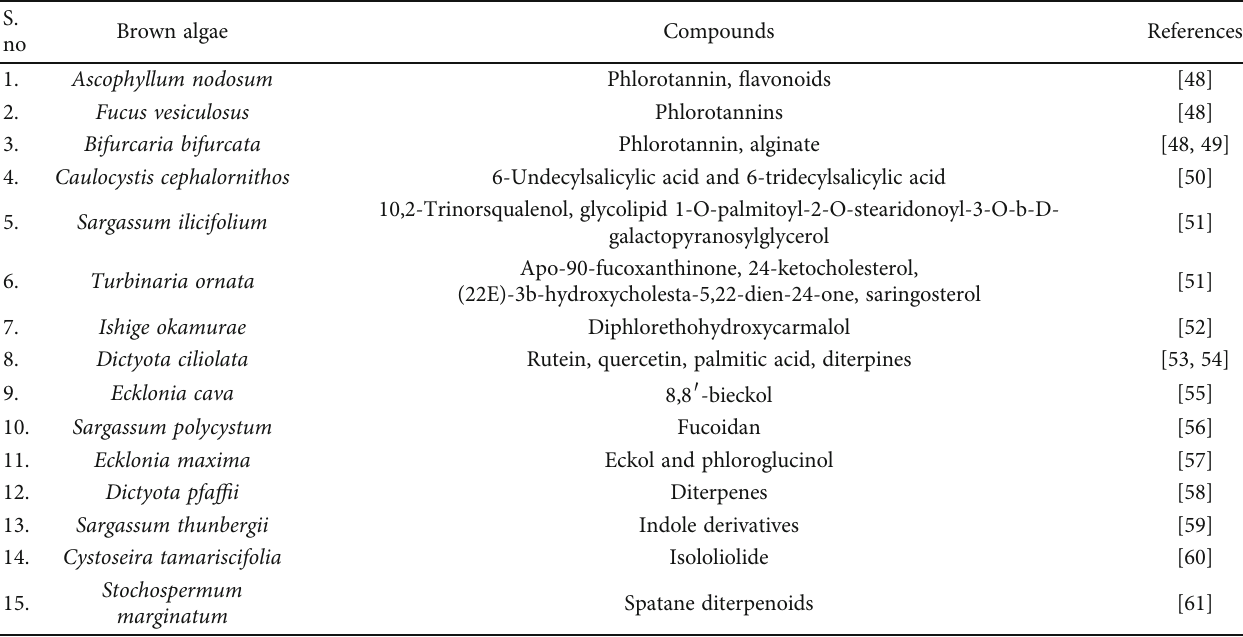
Table 1: List of di ff erent species of brown algae and their